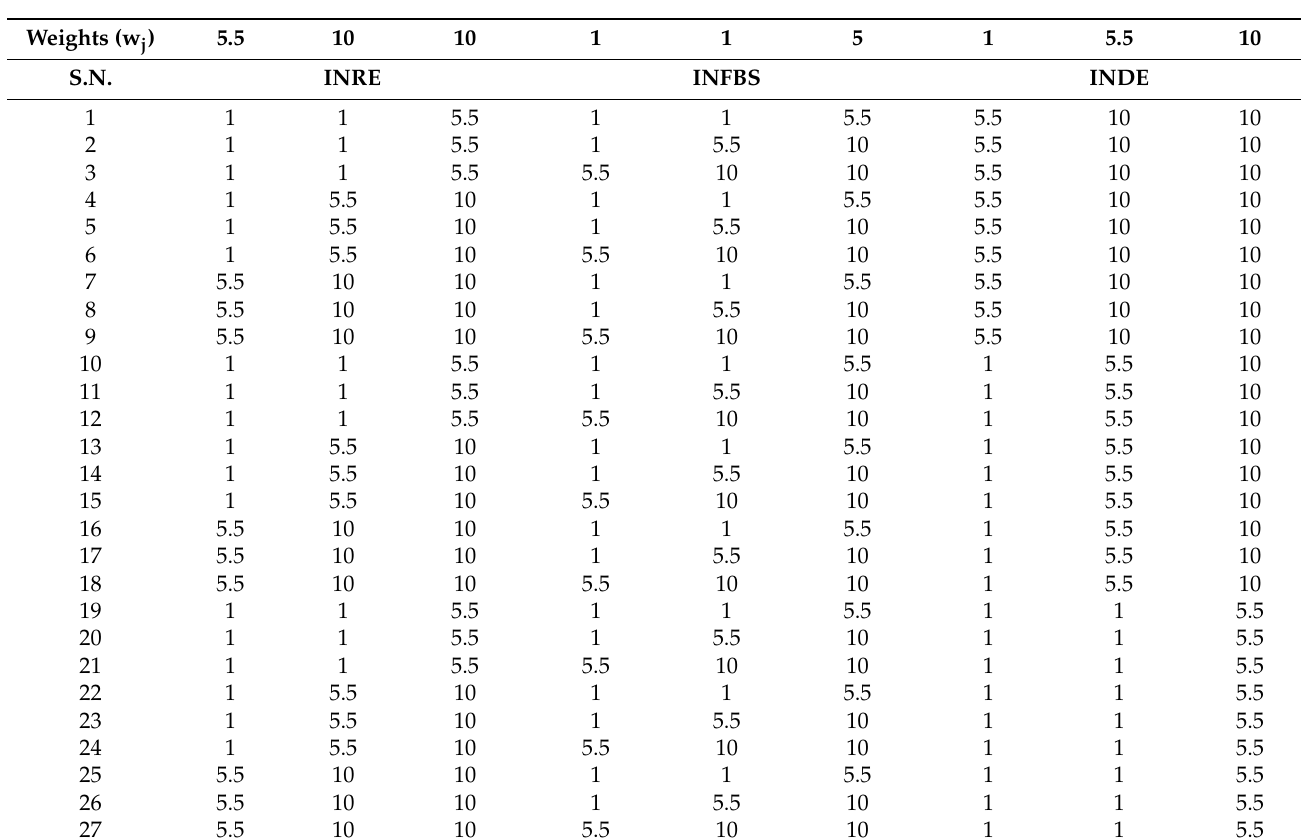
Table 5. Fuzzy rule